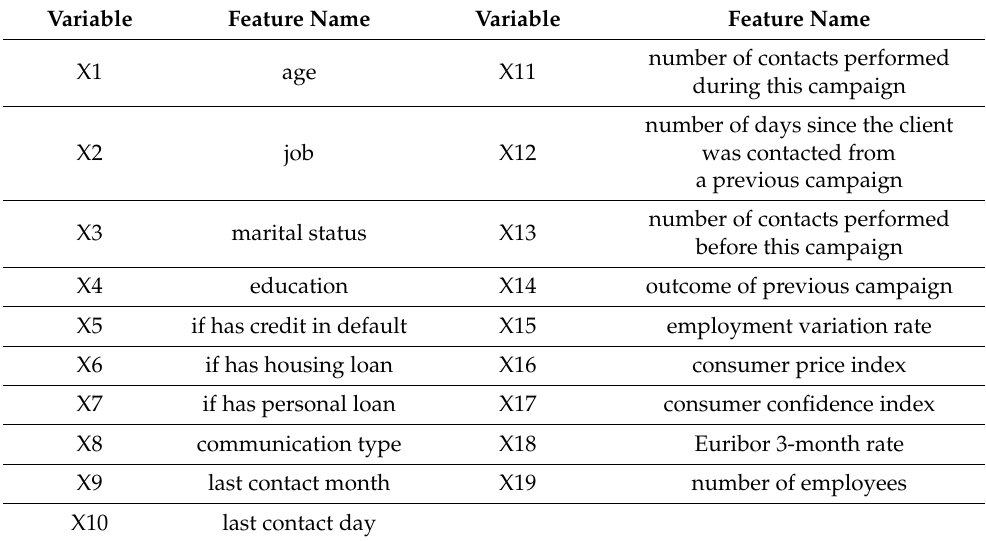
Table 3. Variables on x-axis and their corresponding feature names for dataset 2.